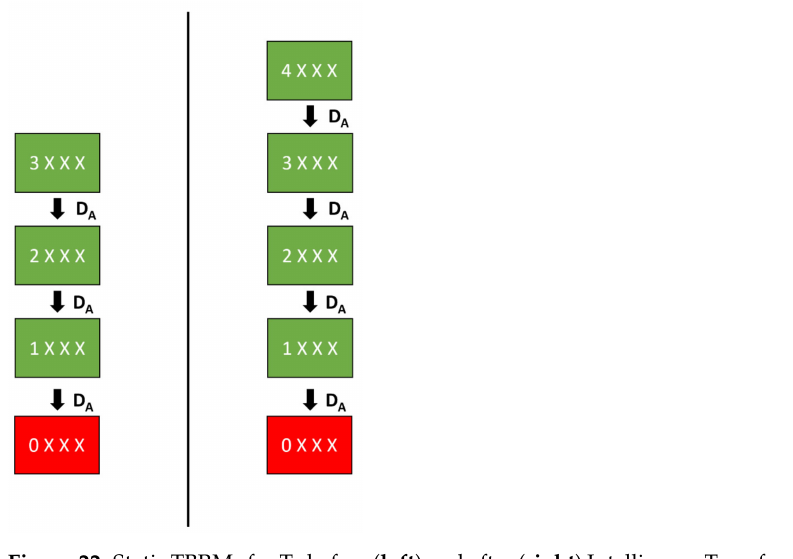
Figure 21. Potential Redundancy Matrix (B*) for the example.